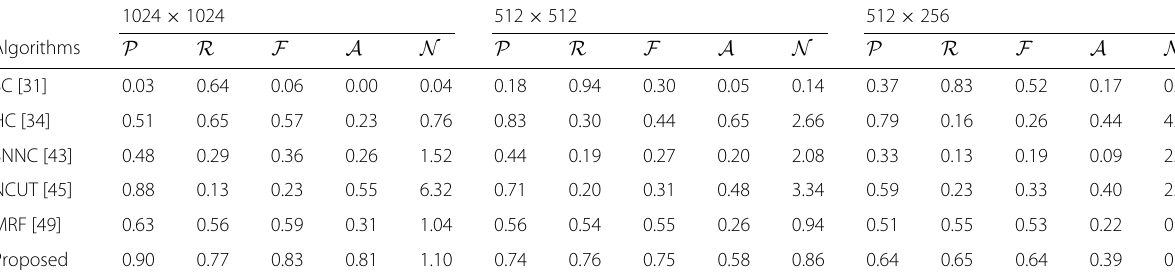
Table 4 Comparison of clustering algorithms on D